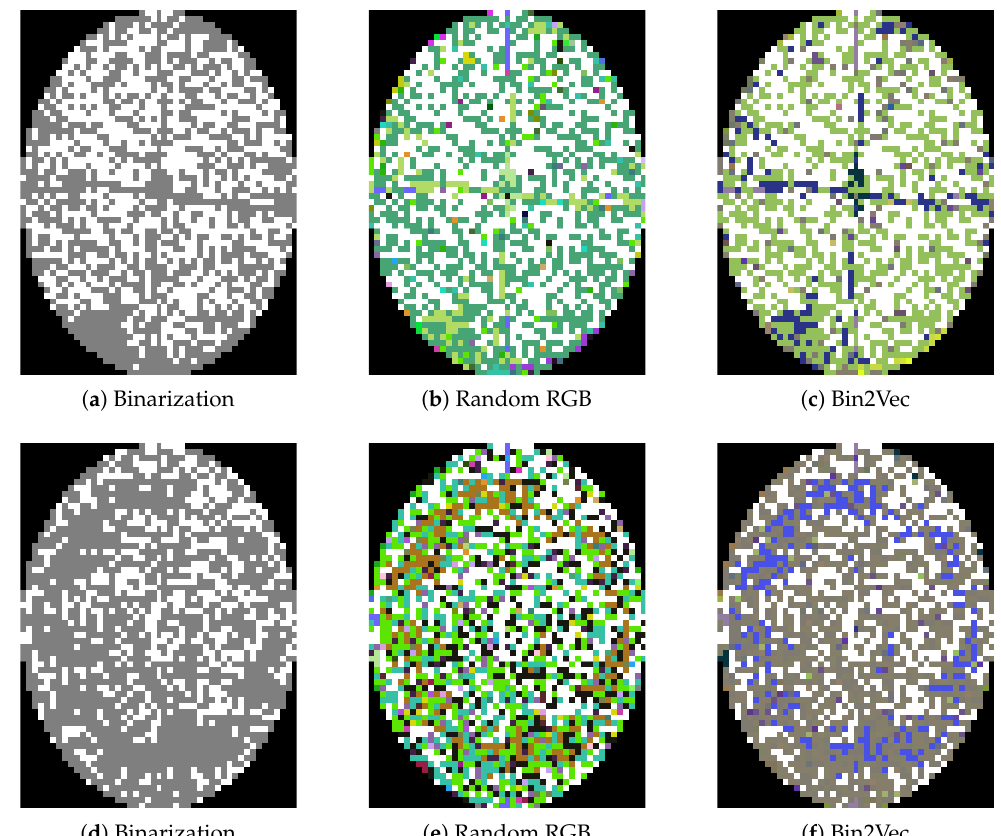
Figure 9. Example of WBM with obvious patterns when visualized by Bin2Vec methodology (Binarization, Random RGB,